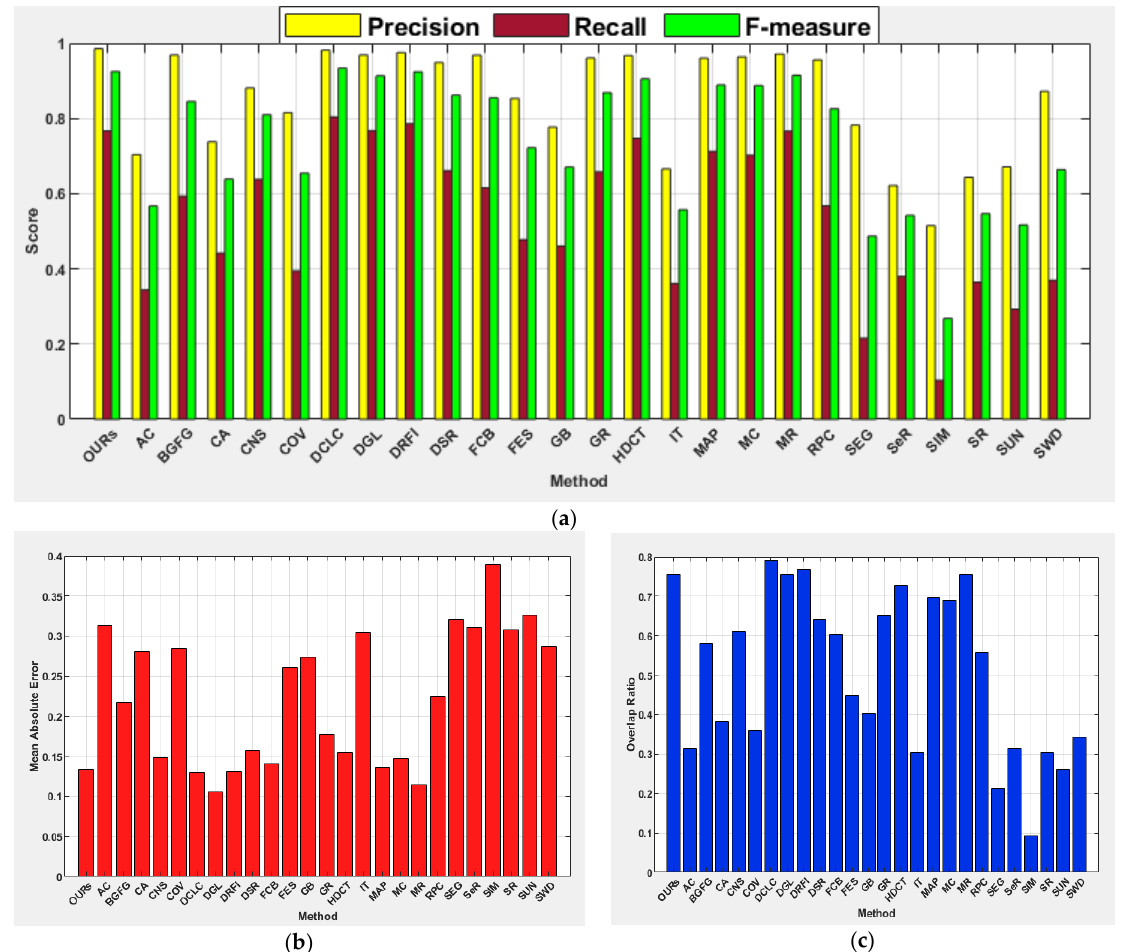
Figure 10. ( a ) F-measure; ( b ) MAE and ( c ) OR on image category: Overlapped objects.